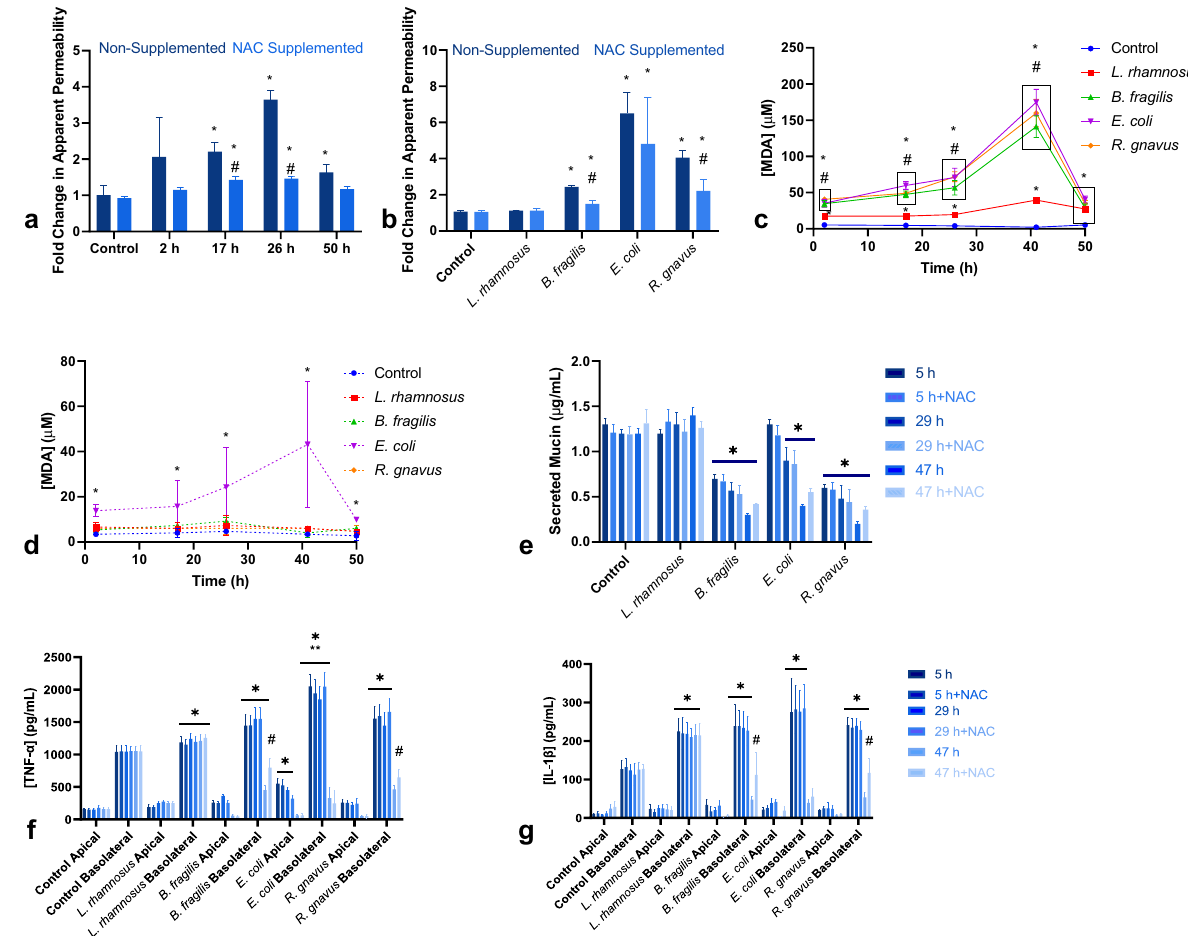
Figure 5. Apical supplementation of NAC reduces MDA and the degree of change in monolayer permeability compared to non-supplemented co-cultures. ( a ) Fold change in apparent permeability of monolayers cultured for 24 h with E. coli spent medium collected from various time points of co-culture experiments, with NAC supplementation and without NAC supplementation [n = 2, * = Significant difference compared to control (17 h p values range from p = 0.04 to p = 0.02, 26 h p values range from p = 0.04 to p < 0.0001, 50 h p = 0.04), # = Significant difference compared to Non-Supplemented samples collected from same timepoint (17 h p = 0.02, 26 h p = 0.009)]. ( b ) Effect of NAC supplementation on the change in apparent permeability of single-species co-cultures after 50 h [n = 10 over 5 independent experiments, * = Significant difference compared to control ( B. fragilis p = 0.02, E. coli, R. gnavus p < 0.0001), # = Significant difference compared to Non-supplemented samples ( B. fragilis p = 0.03, R. gnavus p = 0.001)]. ( c ) Concentration of MDA in apical media over the course of 50 h of co-culture [n = 10 over 5 independent experiments, * = Significant difference compared to control ( L. rhamnosus p values range from p = 0.003 to p < 0.0001, B. fragilis, E. coli, R. gnavus p < 0.0001), # = Significant difference compared to L. rhamnosus co-cultures ( B. fragilis, E. coli, R. gnavus p values range from ns to p < 0.0001), boxed groups share significance]. ( d ) Concentration of MDA with NAC supplementation of apical media [n = 10 over 5 independent experiments, * = Significant difference compared to control ( E. coli p values range from p = 0.01 to p < 0.0001)]. ( e ) Concentration of apically secreted mucin measured from medium collected at 5, 29, and 47 h after bacterial inoculation [n = 6 over 3 independent experiments, * = significant difference compared to control values from corresponding timepoints (B. fragilis, R. gnavus p < 0.0001, E. coli p values range from p = 0.03 to p < 0.0001)] . ( f ) Concentration of TNF-α in the apical and basolateral chambers at multiple time points with and without NAC supplementation. [n = 4 across 2 independent experiments, * = significant difference compared to the corresponding control value, ** = significant difference compared to corresponding L. rhamnosus value, # = significant difference compared to the corresponding non-supplemented value. ( L. rhamnosus p values range from p = 0.04 to p = 0.02, B. fragilis , E. coli , R. gnavus p < 0.0001)]. ( g ) Concentration of IL-1β in the apical and basolateral chambers at multiple time points with and without NAC supplementation. [n = 4 across 2 independent experiments, * = significant difference compared to the corresponding control value, # = significant difference compared to the corresponding non-supplemented value. ( L. rhamnosus p values range from p = 0.03 to p = 0.01, B. fragilis , E. coli , R. gnavus p <